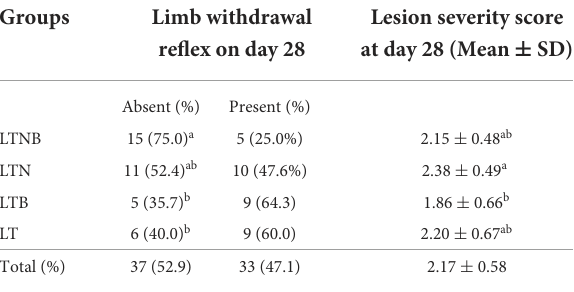
TABLE 6 Lesion severity score (Mean ± SD) and number of cows with and without limb withdrawal reflex.